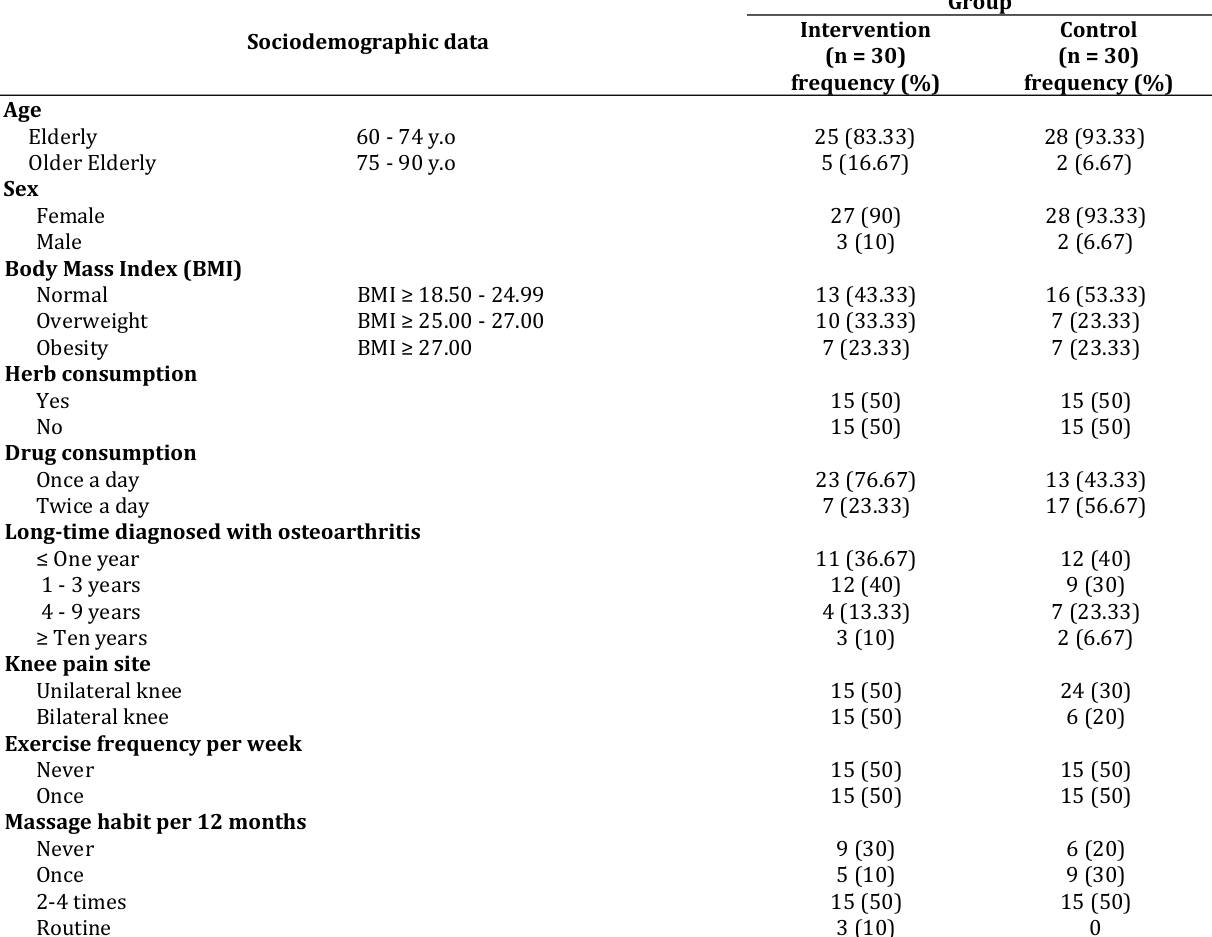
Table 1. Demographic Characteristics of Intervention and Control Groups at Baseline